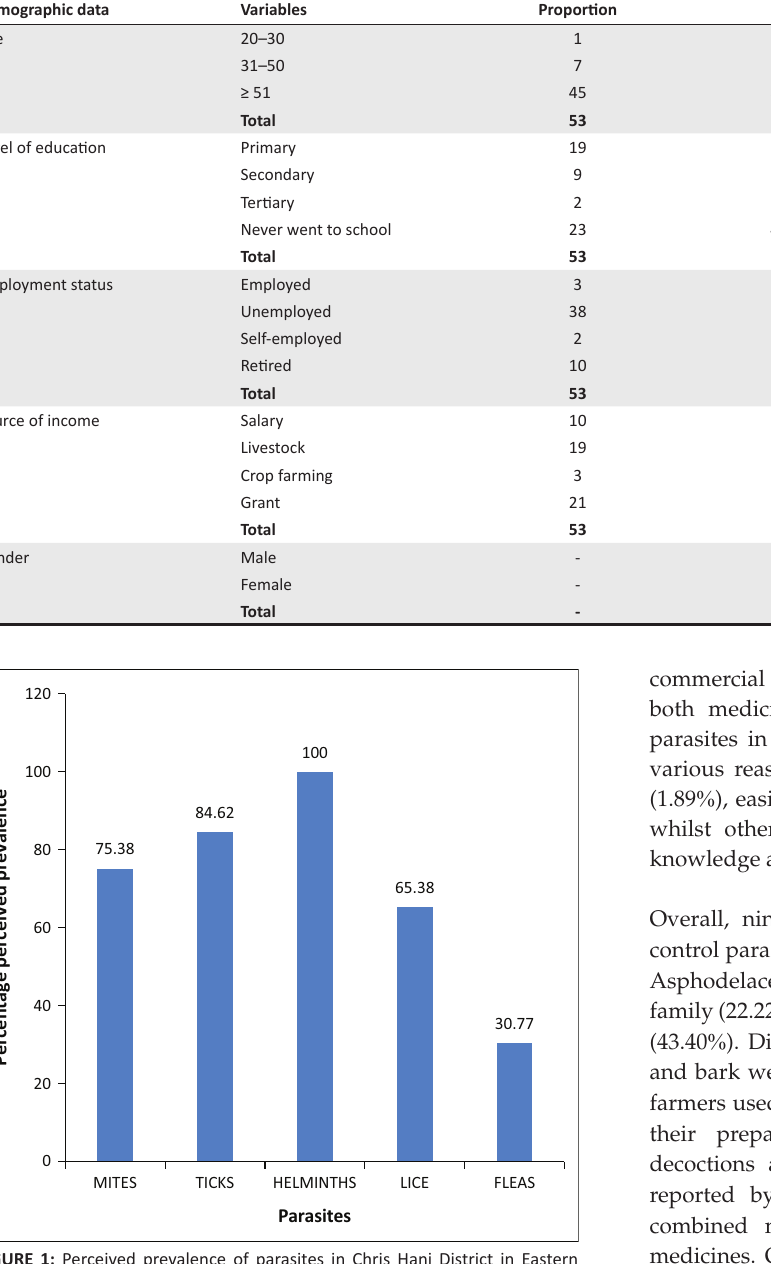
TABLE 2: Demographic data on distribution of respondents. Demographic data